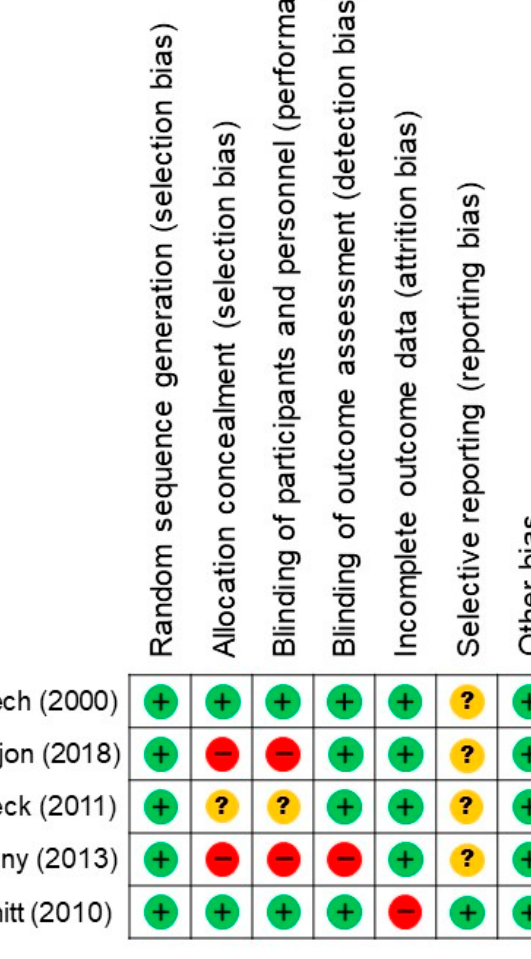
Figure 2. Risk of bias assessment of the randomized controlled trials included in the meta-analysis [13–17]. The symbols “+”, “ − ”, and “?” indicate low, high, and unclear risk of bias, respectively.